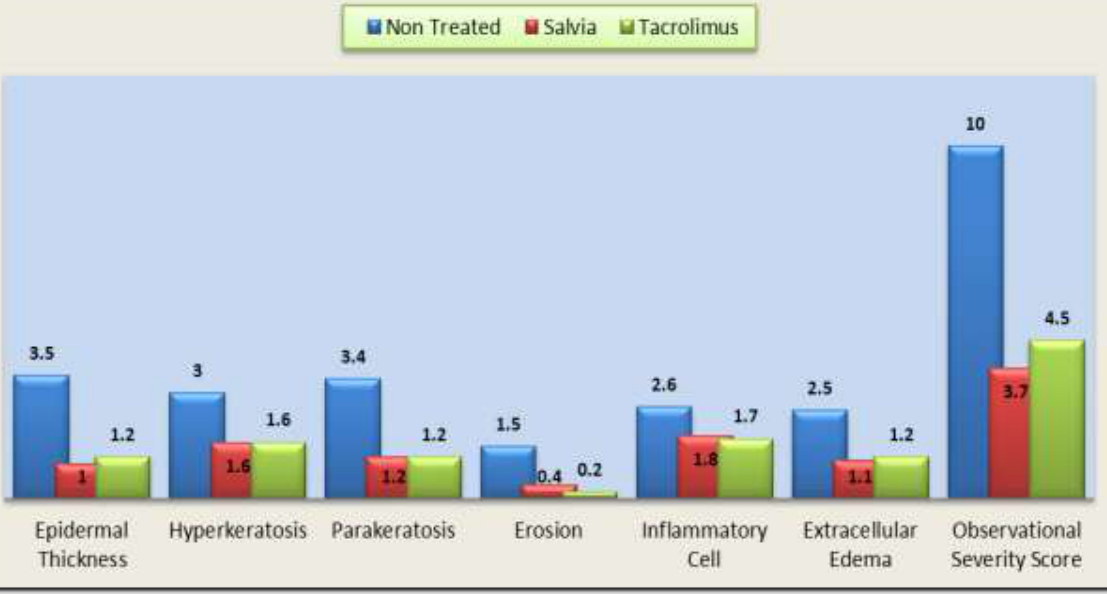
Figure 8. Comparison between phenolic compound of Salvia frigida and Tacrolimus treated groups (by one way ANOVA test) regarding histopathological changes and observational severity score. Results are expressed as mean ± SD, P is significant at ≤